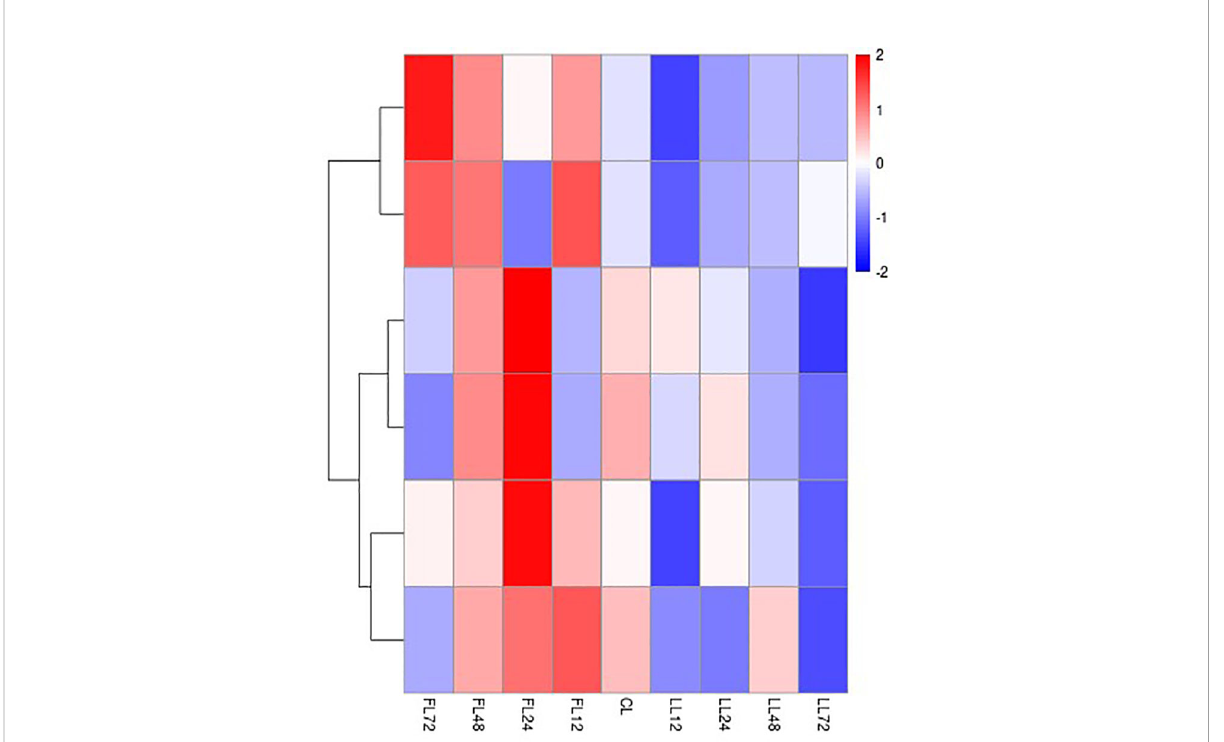
FIGURE 7 Clustering heatmap of DEGs in three pathways. Each column represented a sample, each row represents a gene. Colors represented the gene expression in a single sample, red represented higher expression, while blue represented lower expression. CL was the hepatopancreas tissue of the control group, FL was the hepatopancreas tissue of the V.parahaemolyticus infection group, LL was the hepatopancreas tissue under low salt stress